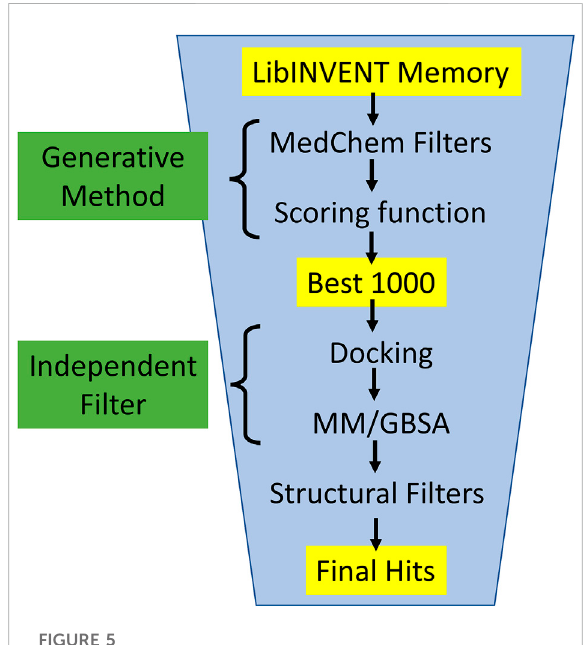
FIGURE 5 Compound evaluation work fl ow: All generated molecules from memory are fi ltered based on physicochemical properties to enforce the generated compounds to be inside a scope that is generally considered as drug-like (MedChem). Then the 1,000 remaining compounds with the highest scores are re- dockedand undergo an MM/GBSA analysis.Onlycompoundswith a MM/GBSA energy of less than − 70 kcal/mol are considered further. In the last step, several structural fi lters are applied to remove compounds with undesired substructures from the fi nal